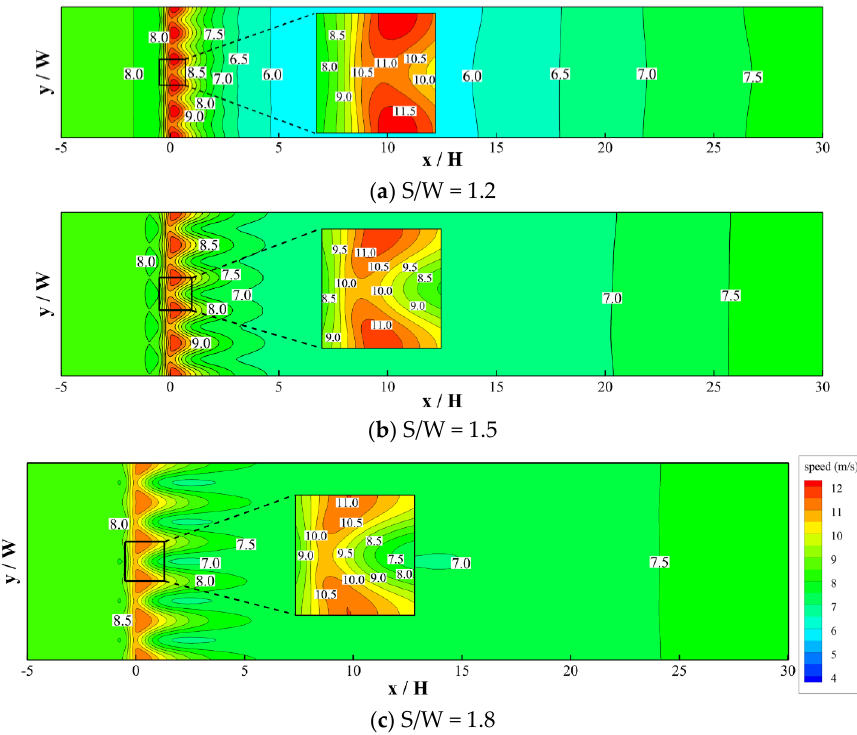
Figure 11. Pedestrian wind speed contours for different tree spaces (H = 9 m).